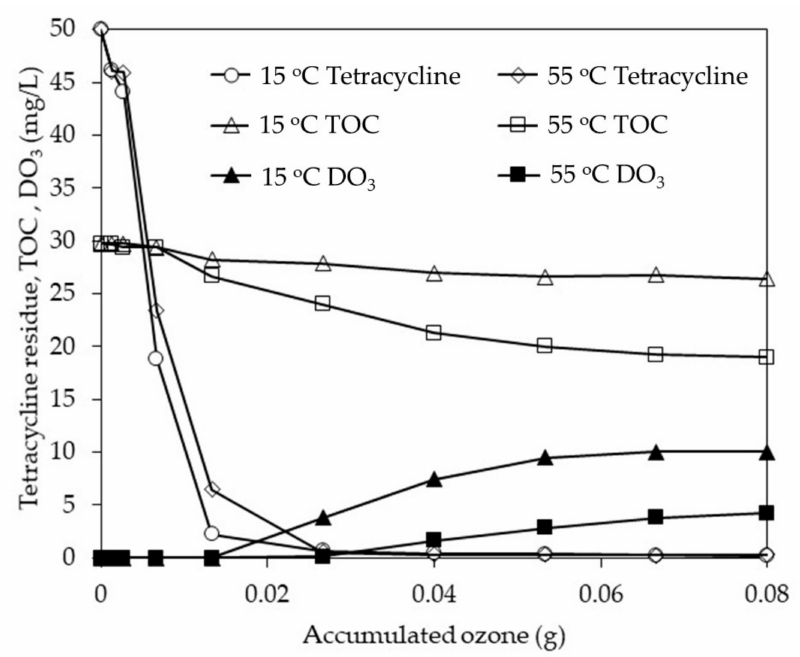
Figure 5. Residual tetracycline and total organic carbon (TOC) in solution during ultrafine-bubble ozonation at different reaction